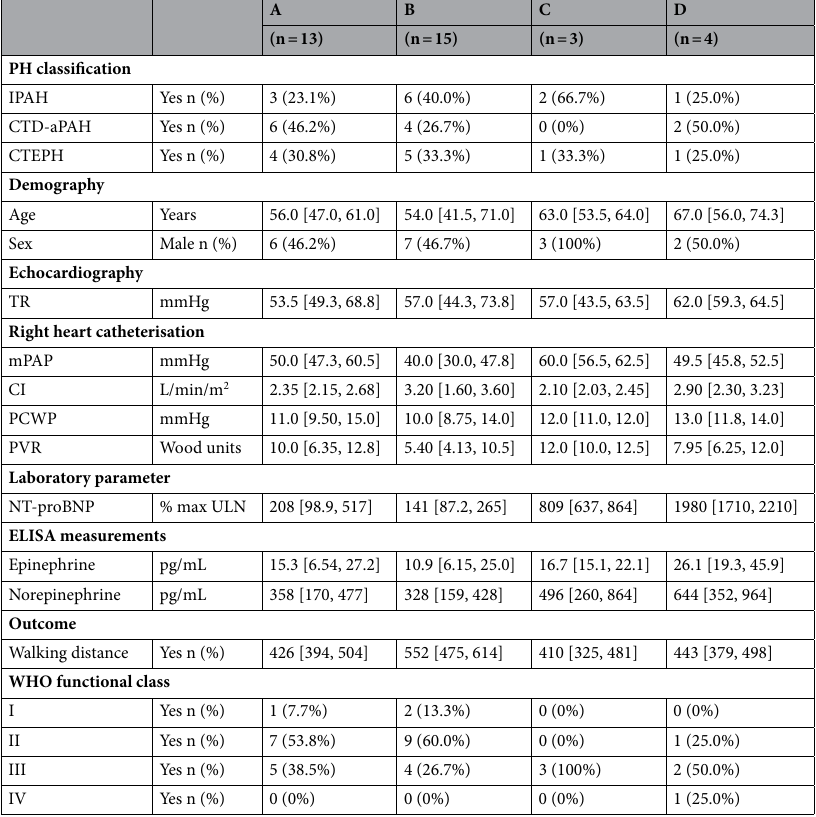
Comparison of cellular metabolic pathway activities in phenotypes A–D.